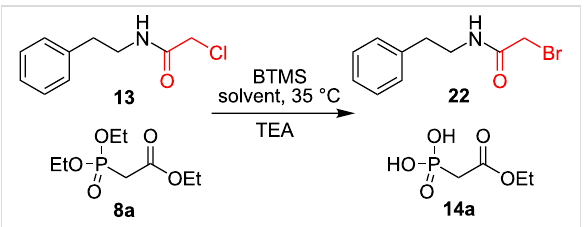
Scheme 6: Exchange of the chlorine substituent with bromine in 2-chloro- N -phenethylacetamide ( 13 ) under McKenna reaction condi- tions.